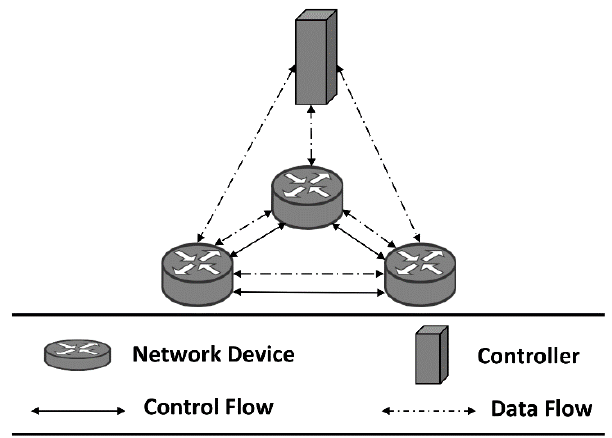
Figure 6. Hybrid Design .